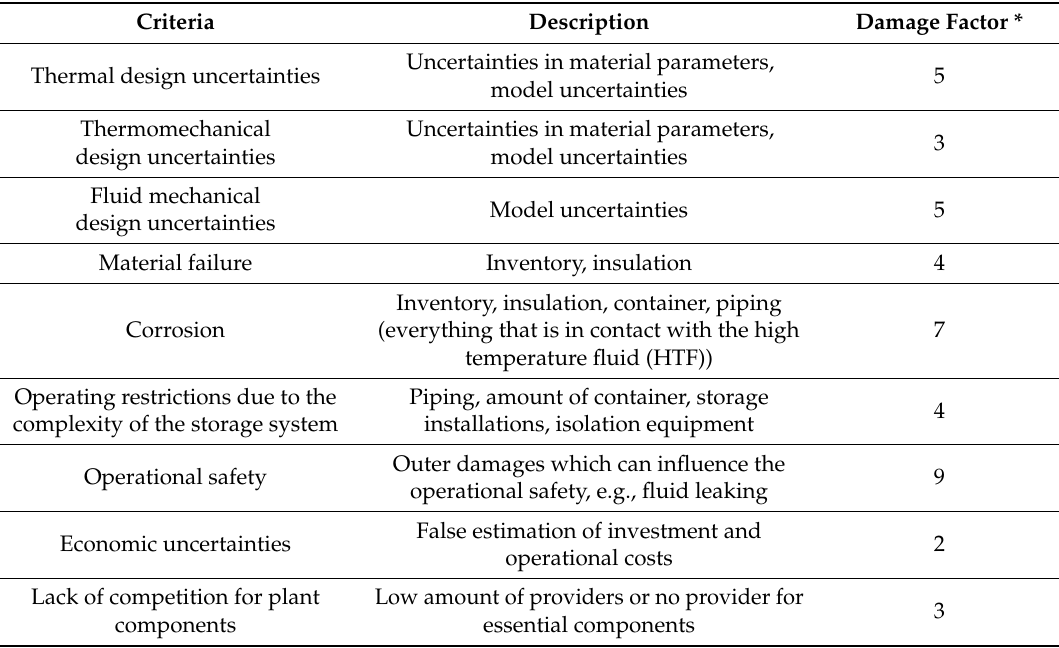
Table 5. Criteria for risk analysis and damage